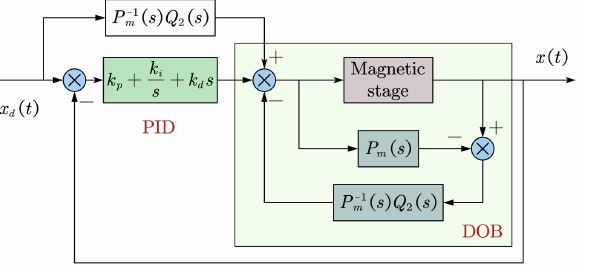
Figure 13. Schematic of the control loop, where k p , k i , and k d are, respectively, the proportional, integral, and differential gains of the PID controller, and Q 1 ( s ) and Q 2 ( s ) are the low-pass filters.